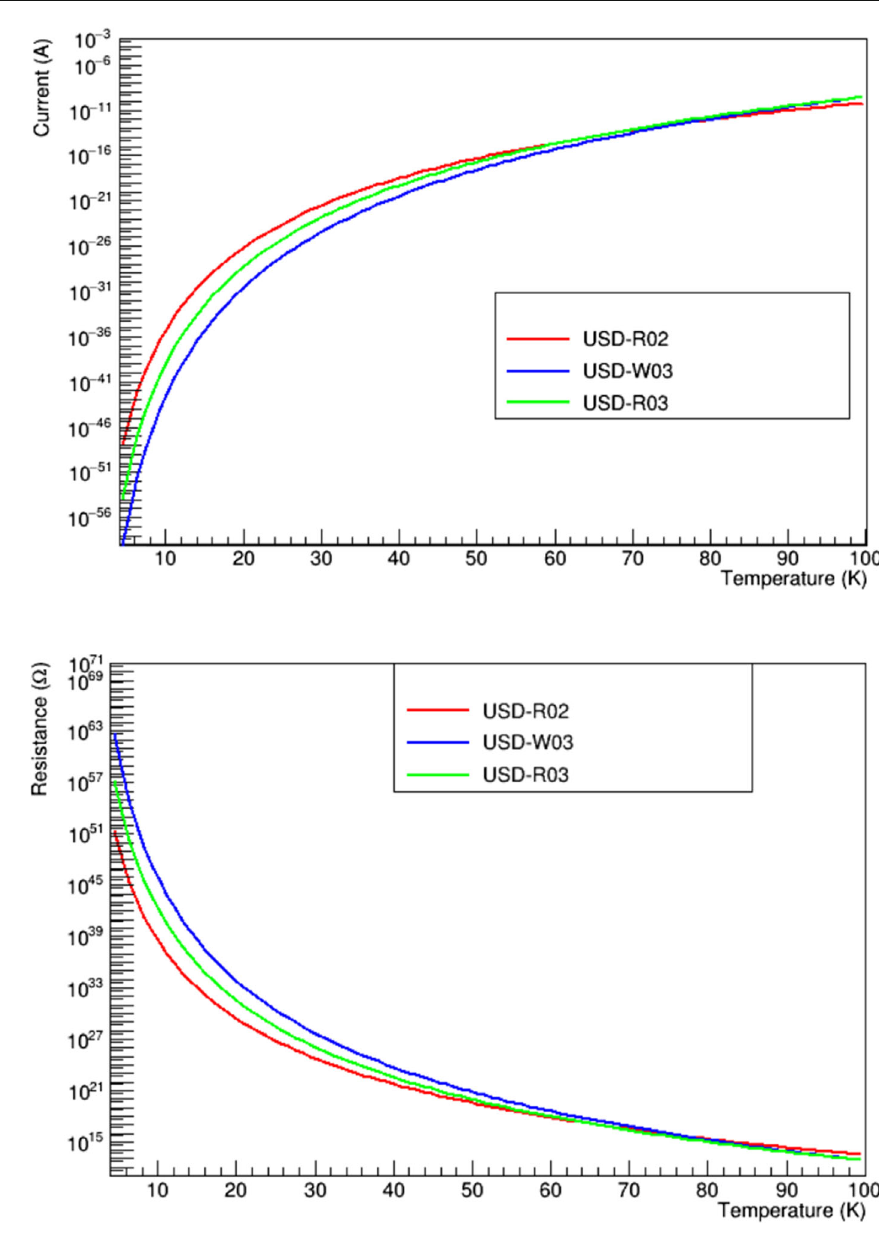
Fig. 9 Projected variation of the surface leakage current with temperature for a PPC detector using the parameters obtained for the a-Ge used in detectors USD-R03, USD-R02 and USD-WO3